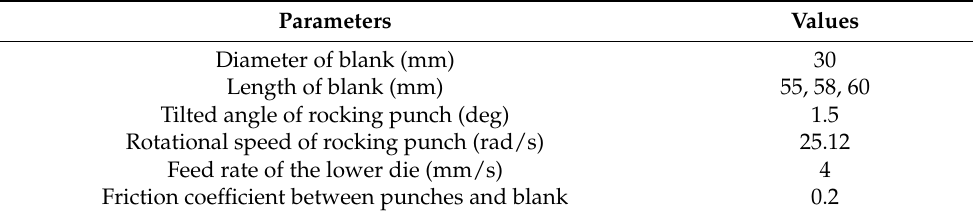
Figure 5. 3D FE models for cold orbital forming of aluminum alloy component with complex shape. Table 1. The simulation parameters for one-step cold orbital forming base. Table 1. The simulation parameters for one-step cold orbital forming base.